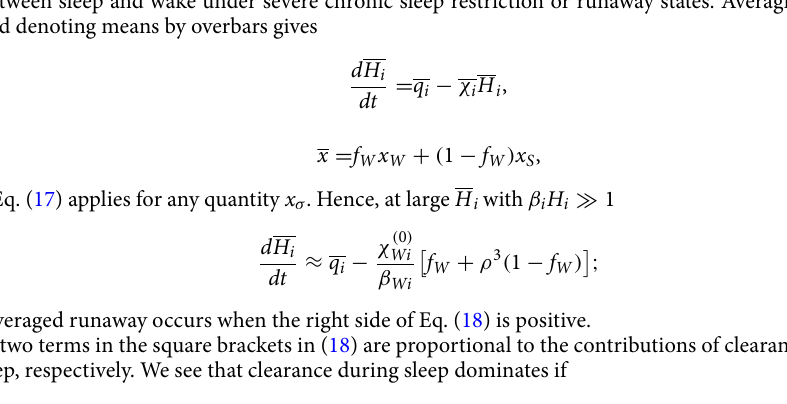
Fig. 2g–j. The case of rising H with β 1 = β 2 = 0 is shown in Fig. 2g. Both H 1 ( t ) and H 2 ( t ) start from 0, rise toward stable fixed-point values of 4.7 and 2.5, respectively, in accord with the detailed expressions in Supplementary Materials S2. Consequently, their sum H ( t ) reaches 7.2. For values β σ 1 = 0.05 , β σ 2 = 0.15 , the dynamics are similar to those for β σ 1 = β σ 2 = 0 , but reaching higher fixed points for both species, as shown in Fig. 2h due to the slower clearance. It is clear that in both Fig. 2g,h H ( t ) reaches a fixed stable point after an initial rise, but the values with nonzero β σ i are higher, in accord with Supplementary Material S2. In Fig. 2i the system satu- rates at H 1 = 12 and H 2 = 6.4 because the runaway condition (14) is not satisfied. In these cases and for small β σ i the dynamics of the individual species are nearly independent. However, runaway occurs if β σ 1 increases beyond 0.14. In this case it is not only species 1 that runs away approximately linearly in time but also species 2, which is slaved to it, as shown in Fig. 2j. As β σ 1 becomes larger, the ratio H σ 2 / H σ 1 approaches a constant